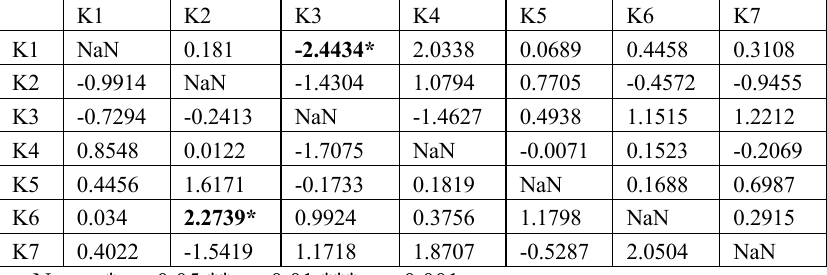
Two-sample t test during RR in the SI